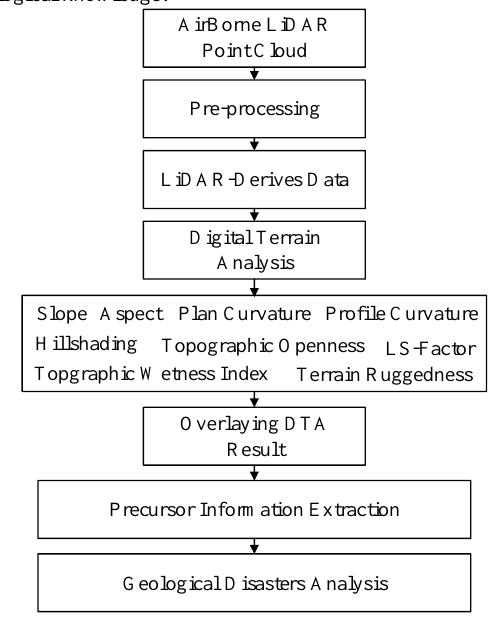
Figure 3. Flowchart of early identification of geological hazards based on airborne LiDAR technology